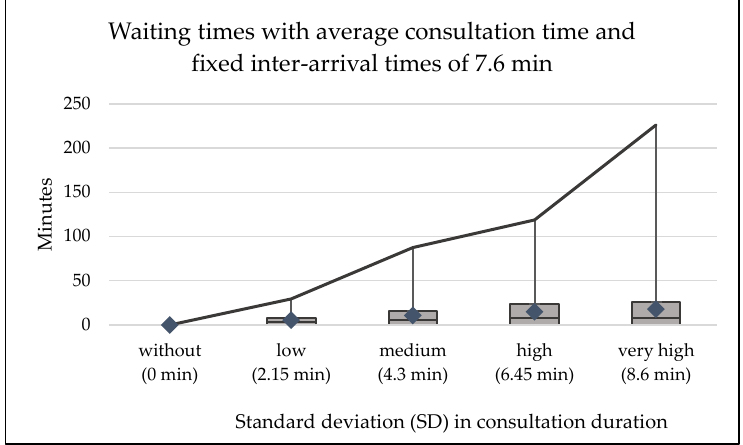
Figure 2. Average, 25%, 75%, and maximum patient waiting times for various standard deviations (in parentheses) in consultation times if only patients with appointments arrive on time every 7.6 min.